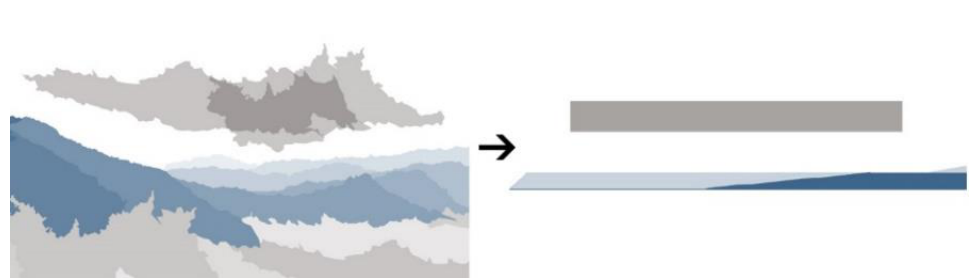
Figure 2. Concept image and roof plan of Lanzarote Dynamic Square.